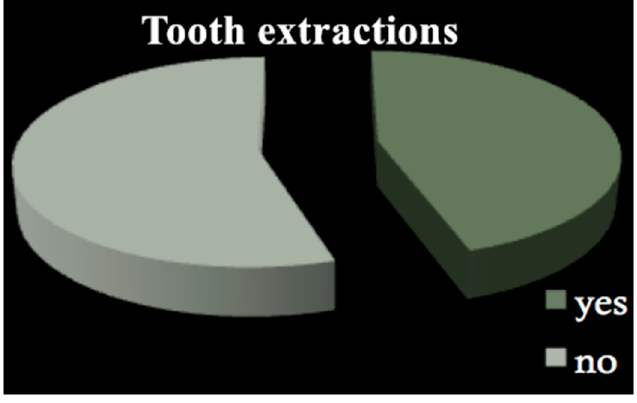
Figure 3. Tooth extractions.